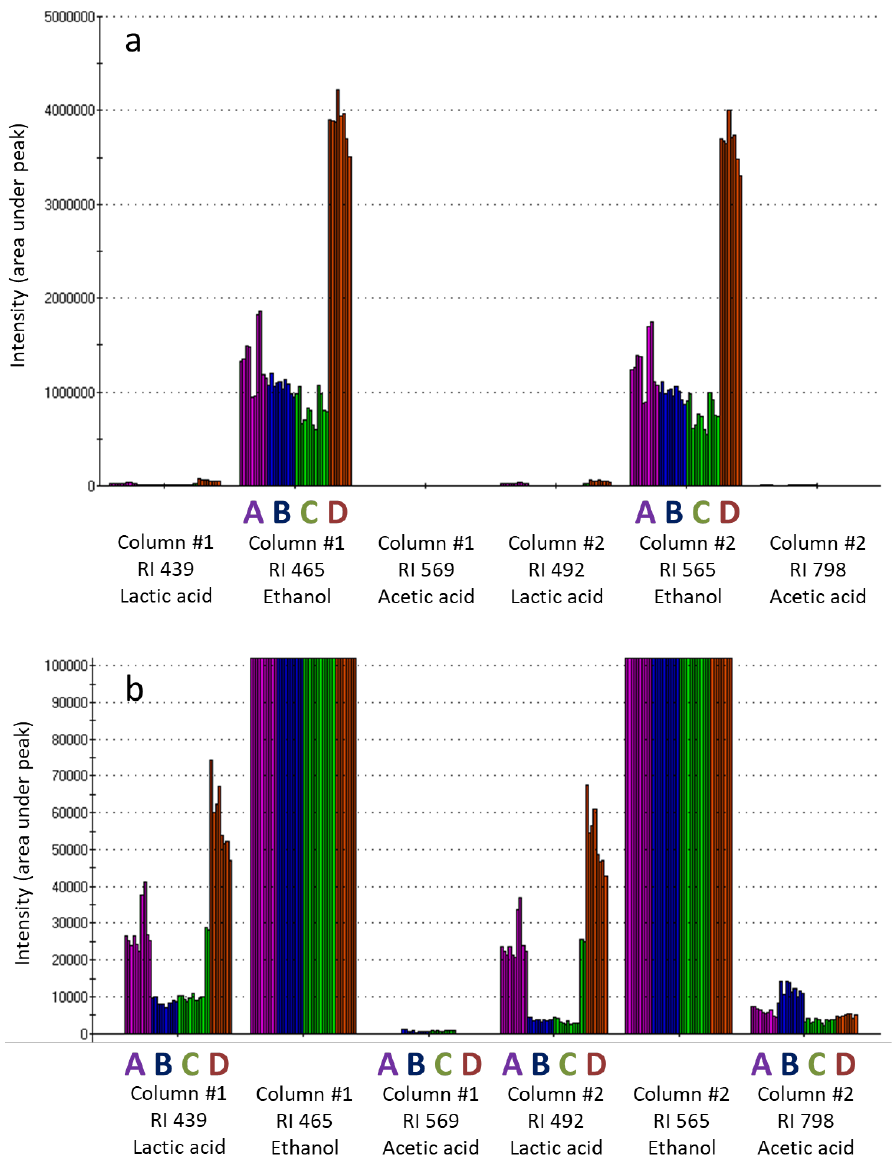
Figure 1. Bar graphs of the intensities measured with the electronic nose at the retention indices (RI) corresponding to lactic acid, acetic acid and ethanol for the ensiled mixtures at day 90, with the indication of mixture type (A, B, C, D), GC column type (#1: Restek MXT-5; #2: Restek MXT-1701), retention indices and respective chemicals. ( a ) showing intensity values corresponding to ethanol; ( b ) as a zoomed image of ( a ) to overcome magnitude differences showing intensity corresponding to acetic acid and lactic acid.